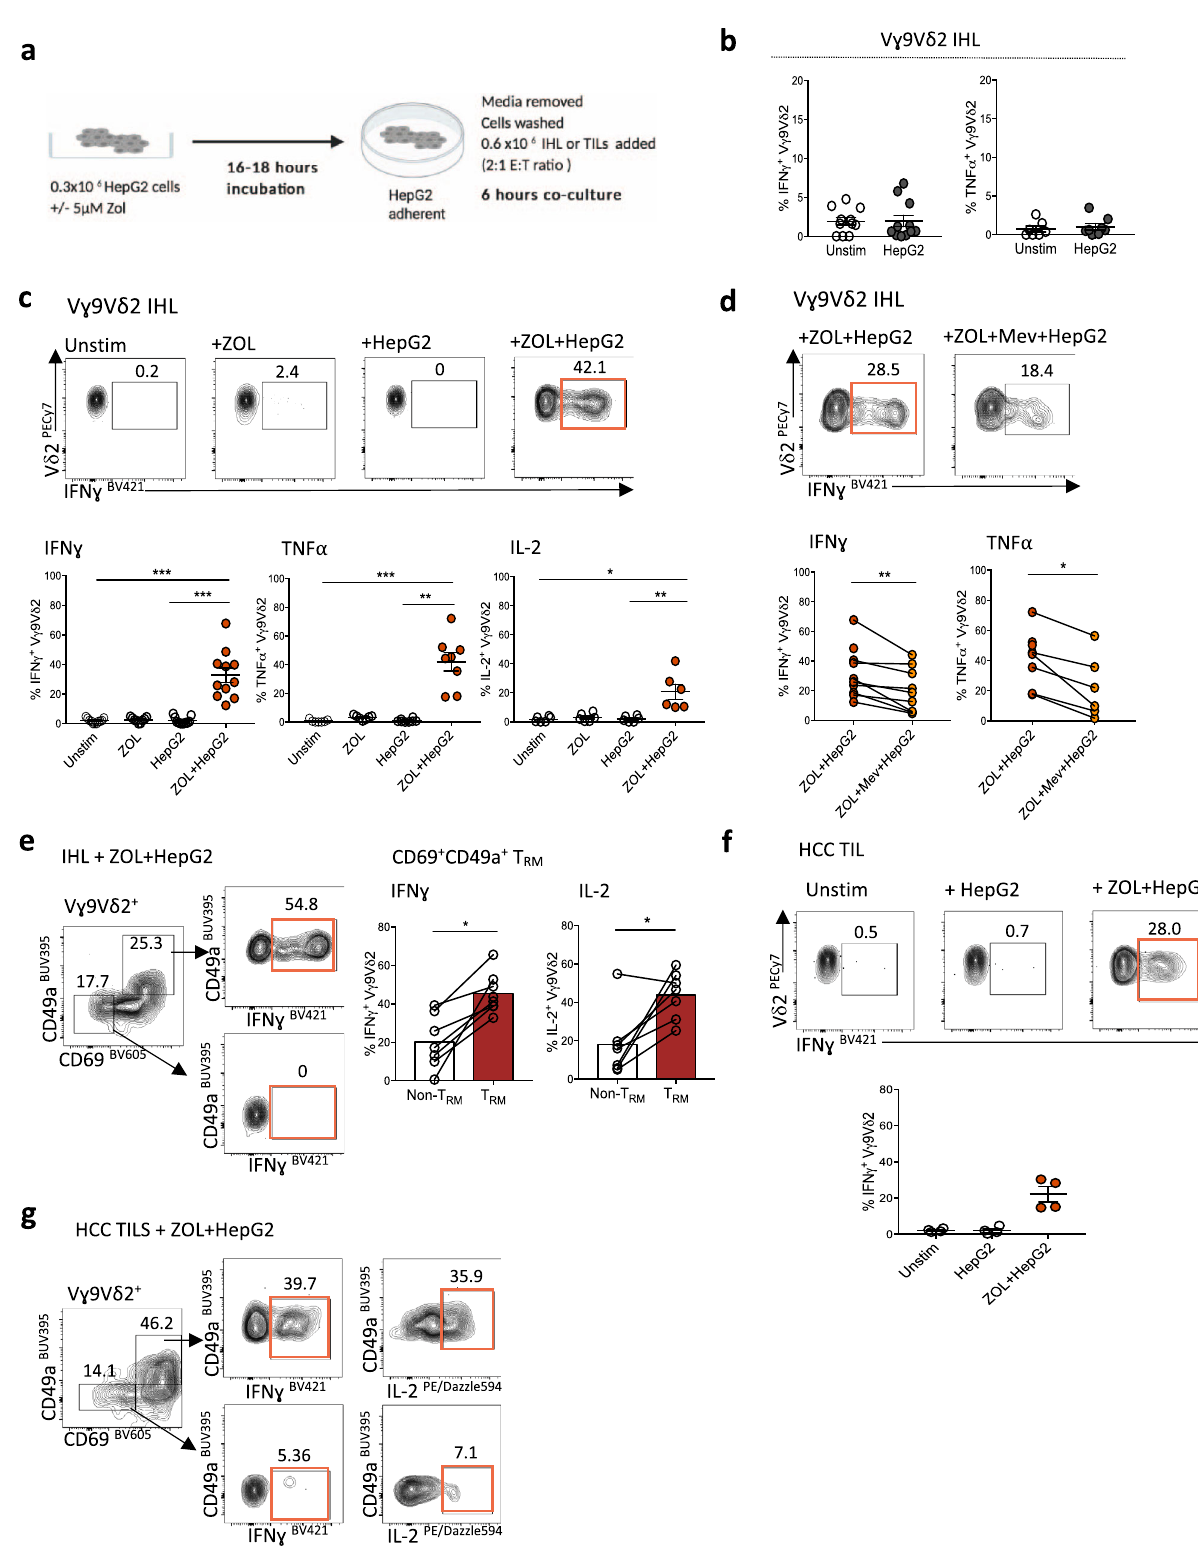
acquire phenotypic and functional features of tissue residence in human HCC. We con fi rm the bona fi de T RM status of CD69 + CD49a + γδ T-cells by demonstrating their lack of egress into hepatic vasculature, long-lived persistence in human liver allografts, and rapid production of cytokines favouring survival and non-cytolytic functionality, similar to intrahepatic αβ CD8 +